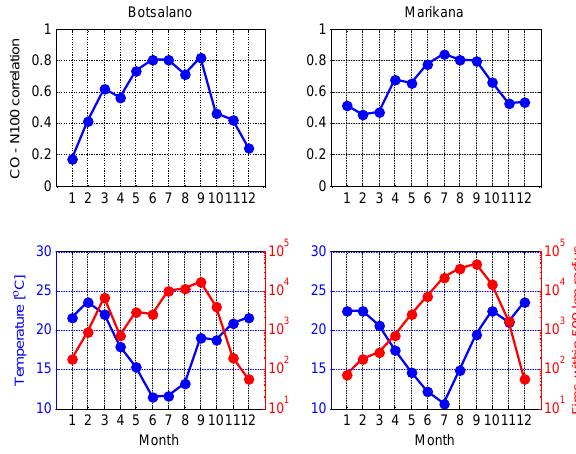
Fig. 11. On the top are presented the monthly correlation coefficient for CO and N 100 concentrations for Botsalano and Marikana. The correlation coefficient has been calculated for hourly median CO and N 100. On the bottom are presented the monthly median tem- perature and the number of MODIS burned area fire observations within 500km radius of Botsalano (left panel) and Marikana (right